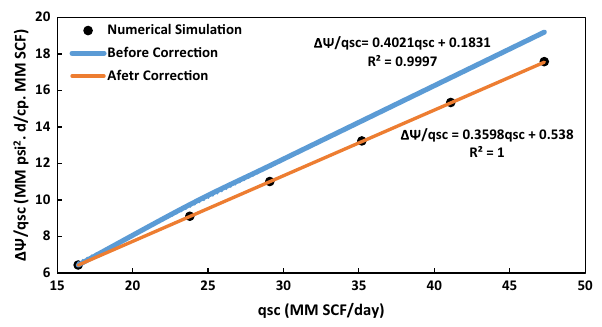
k v h ) on the error between